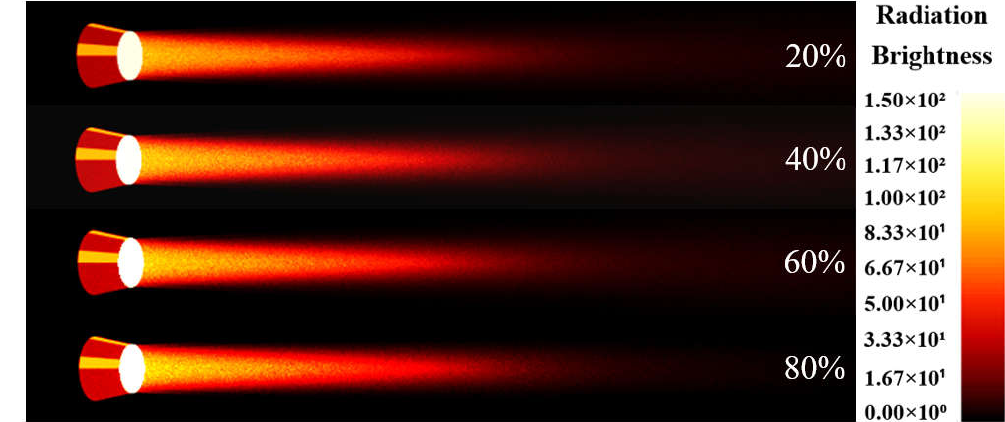
Figure 16. Imaging comparison of different damage degrees at 60 ◦ .